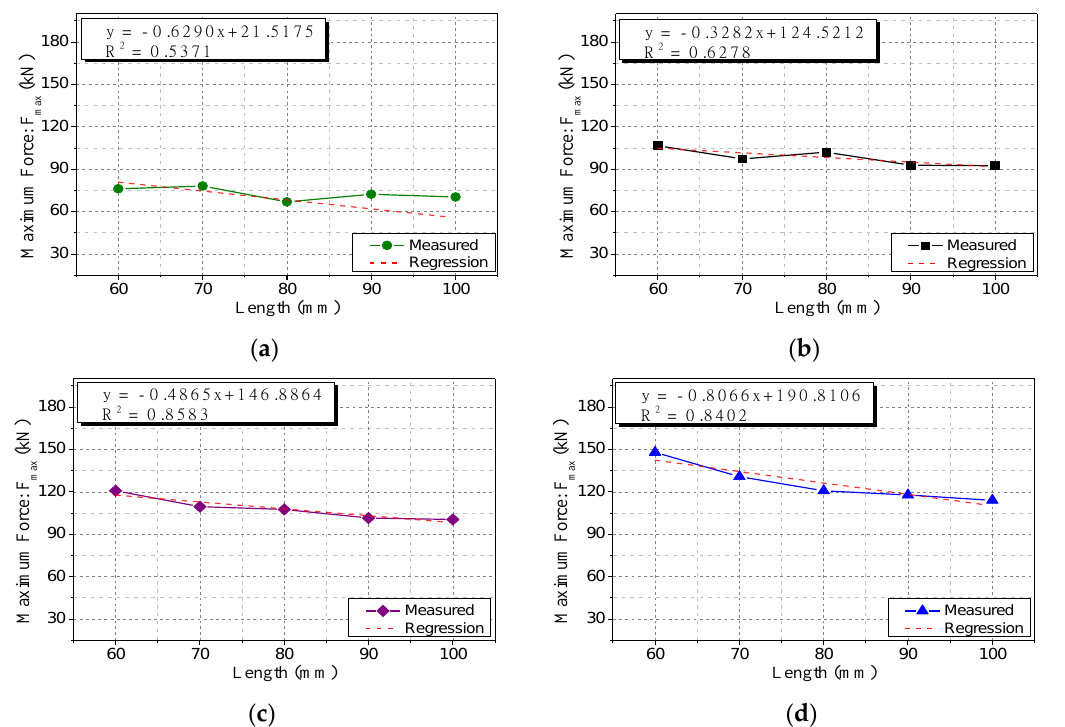
Figure 12. Relationships between stiffness, length, and maximum force. ( a ) Type 2-25%; ( b ) Type 2-30%; ( c ) Type 2-35%; ( d ) Type 2-40%.